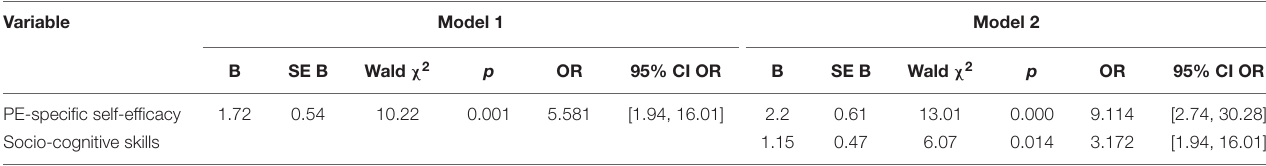
TABLE 7 | Summary of logistic regression analysis for perceived functional socio-cognitive change (mean value) predicting PE-specific self-efficacy at T2 in the study sample ( n = 105). Variable